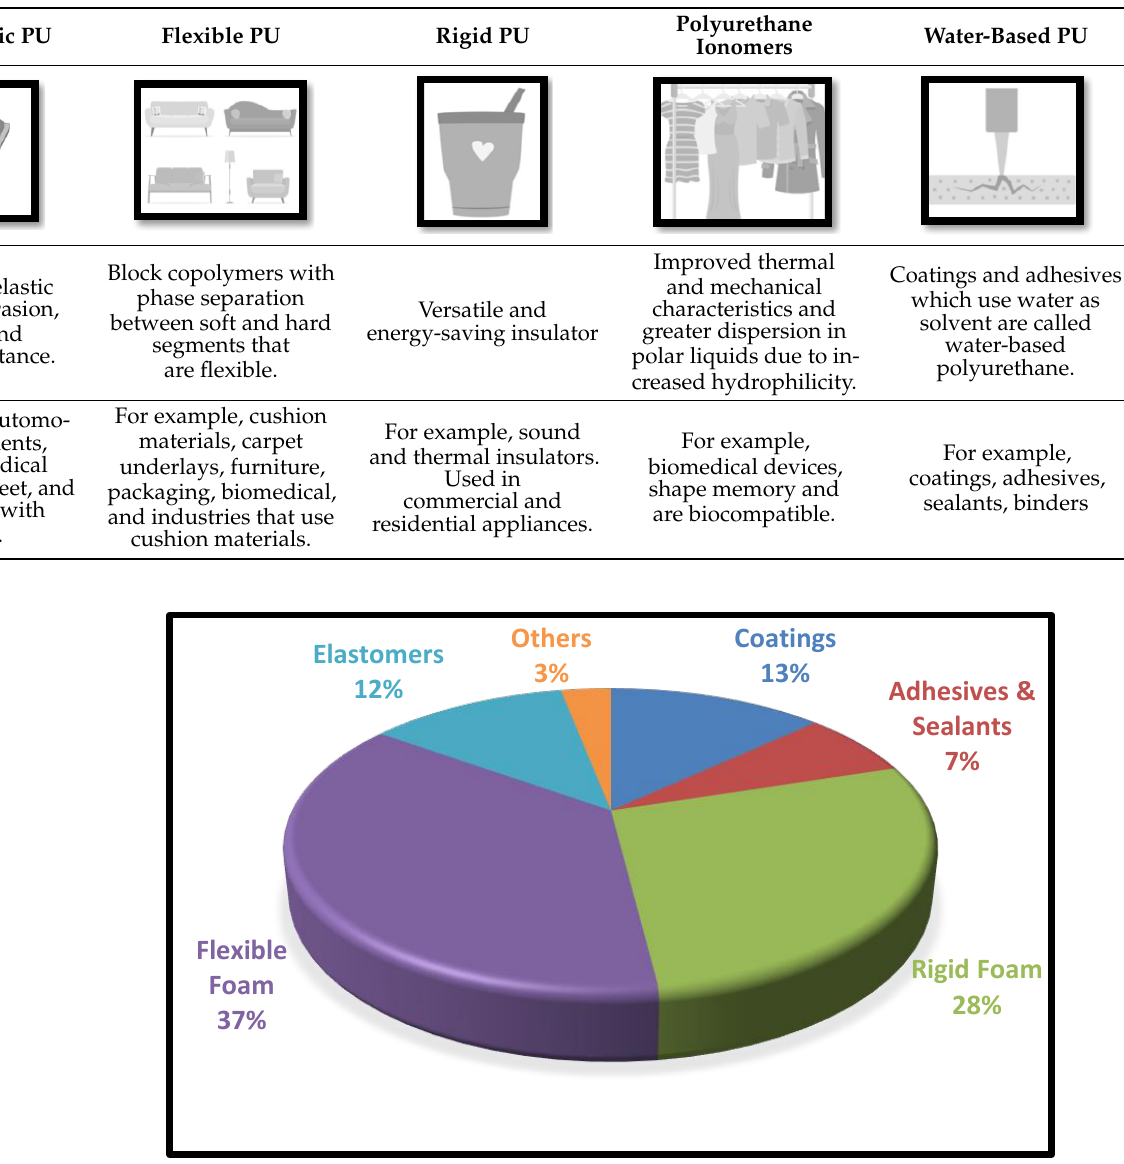
Table 1. Wide Range of Applications Associated with Polyurethanes.